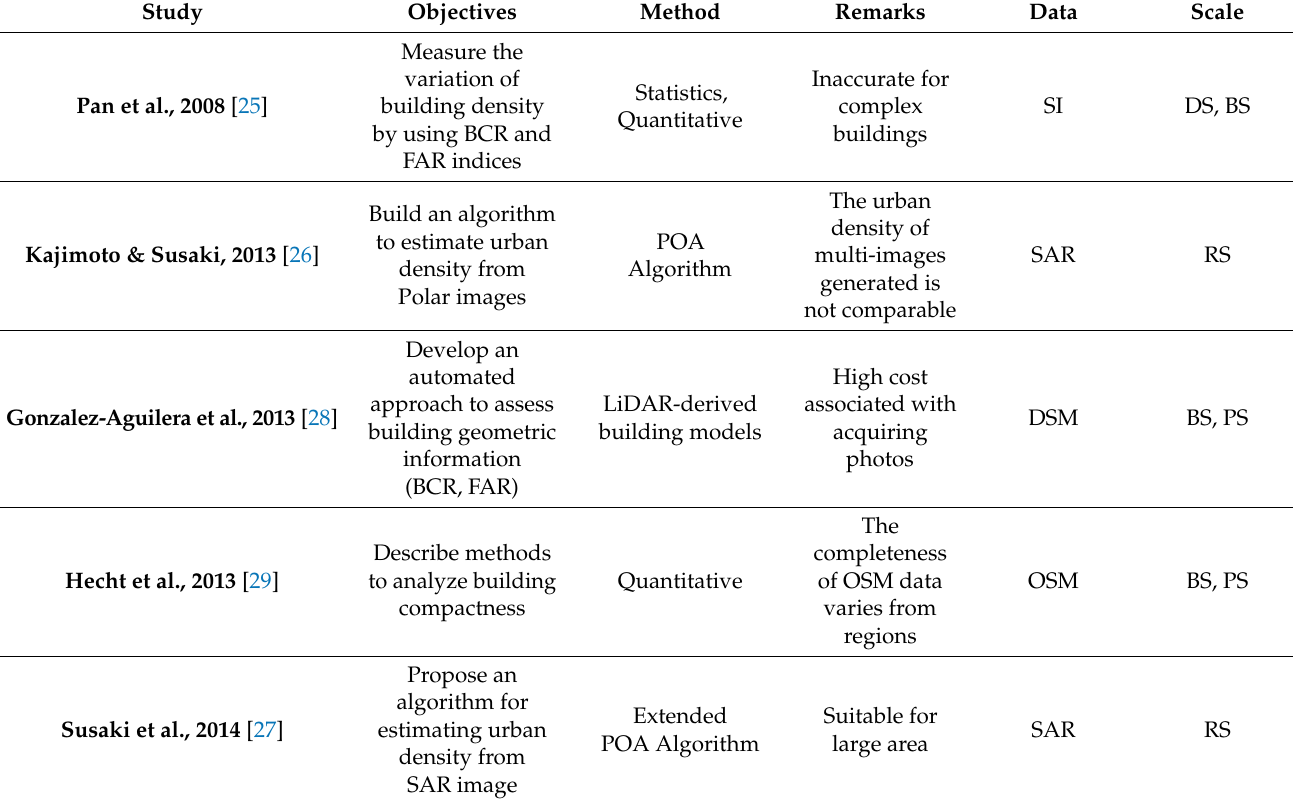
Table 1. Summary of Previous